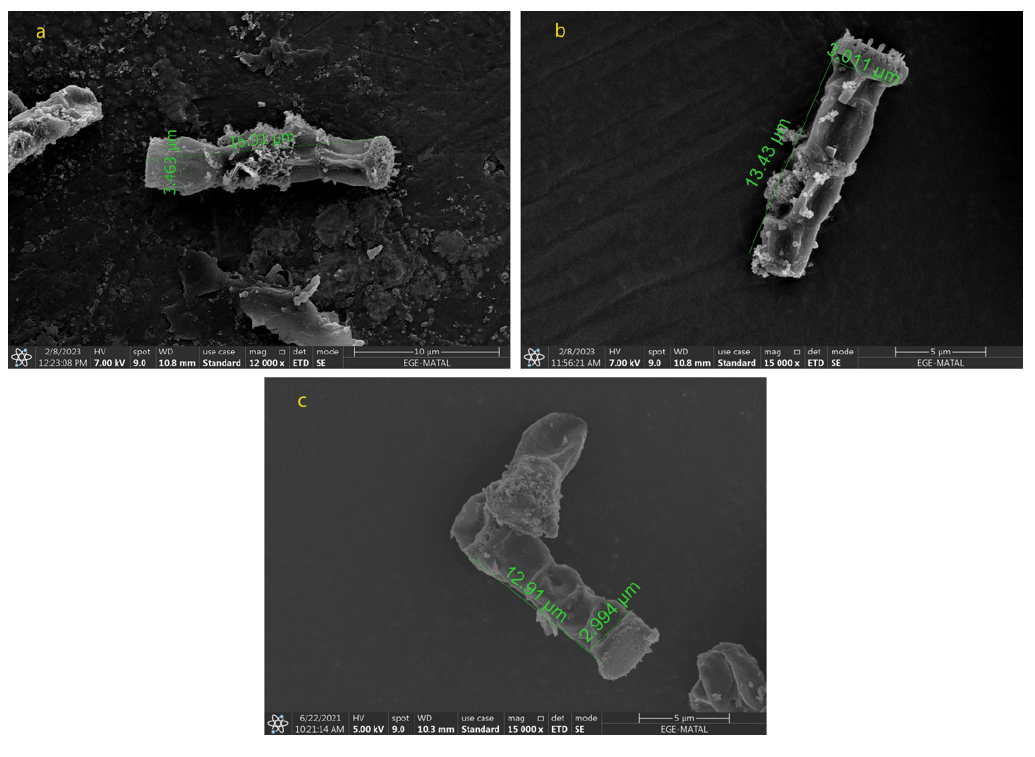
Fig.4 Figure 4. Morphological changes of N. shiloi in response to different light intensities ( a ) N 5-50 ( b ) N 5-300 and ( c ) N 5-150 . Fig.4